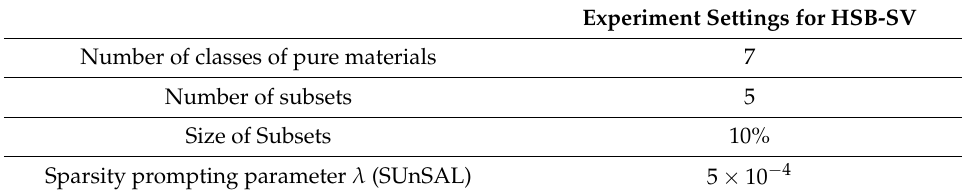
Table 4. Considered parameters for